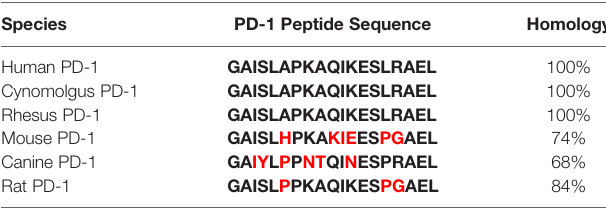
Colored letters indicate the difference of the amino acid with the human